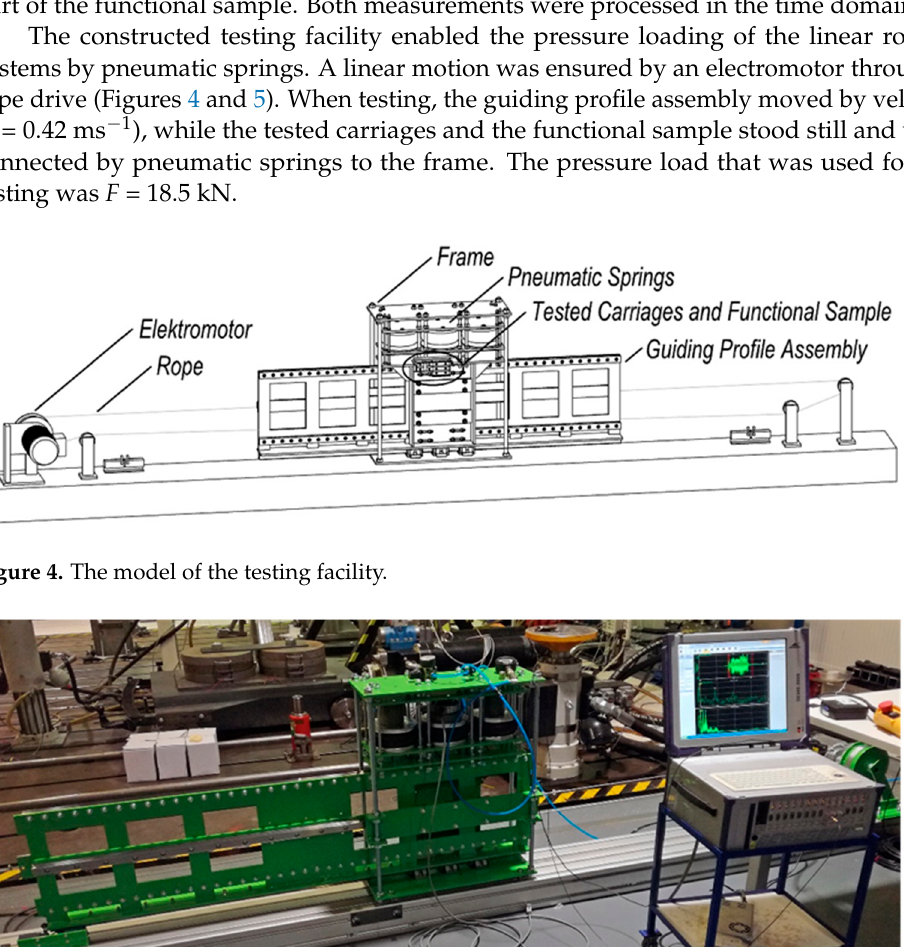
Table 1. Parameters of Hiwin linear rolling system.